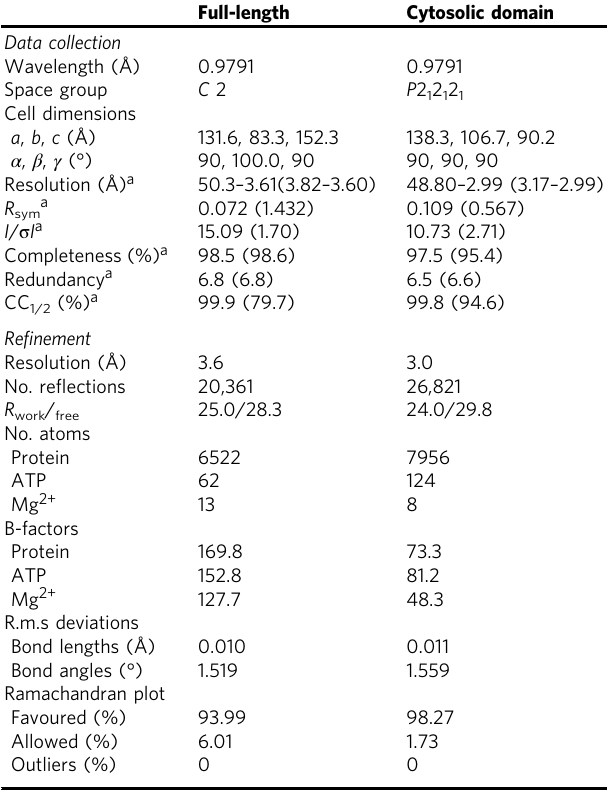
Table 1 Data collection and re fi nement